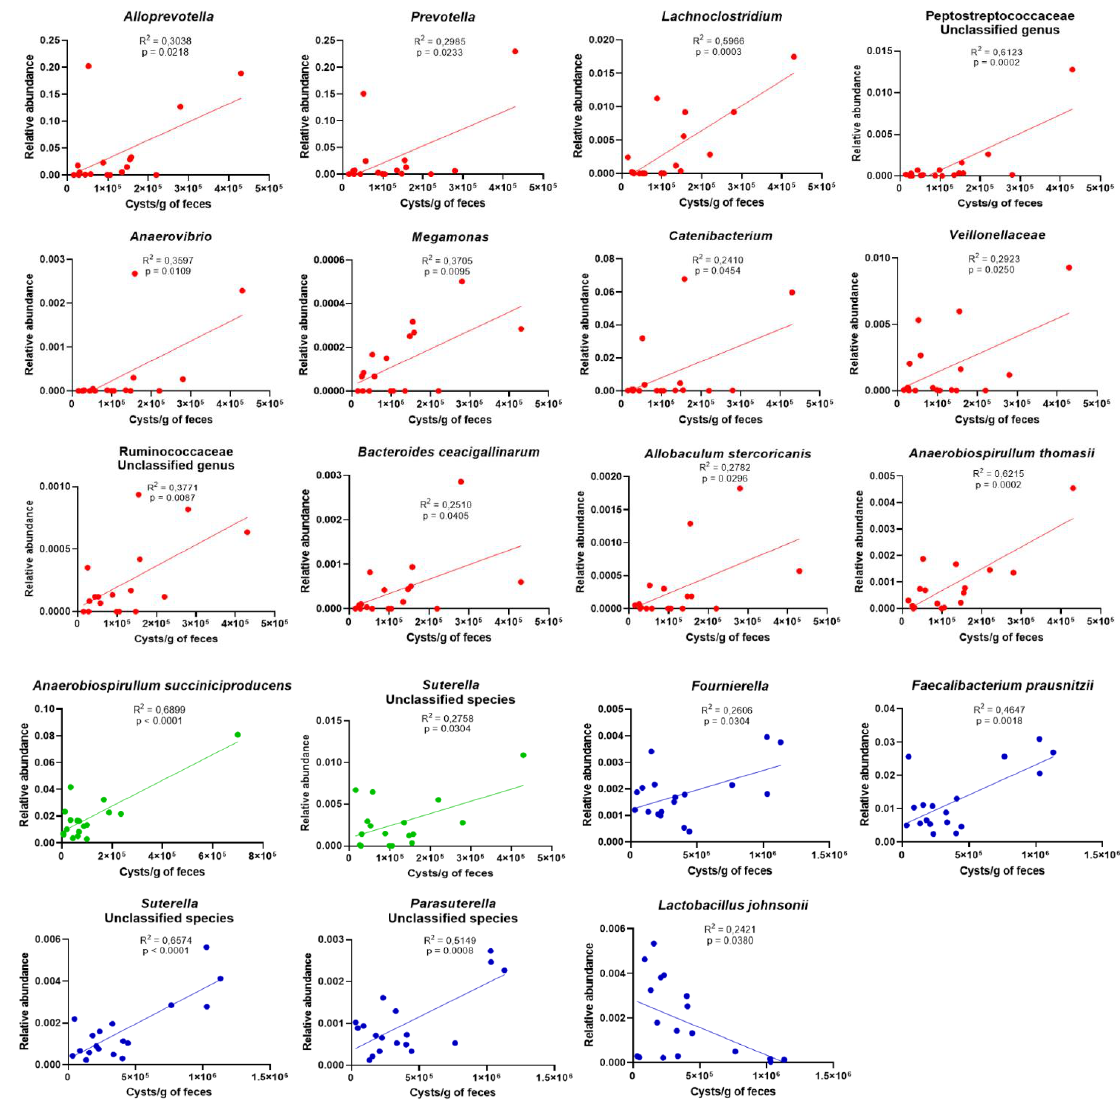
Figure 8. Correlation between cysts shedding and OTU relative abundance in samples D−8 (red), D42 (green), and D85 (blue). The correlation was determined using Pearson’s coefficient.